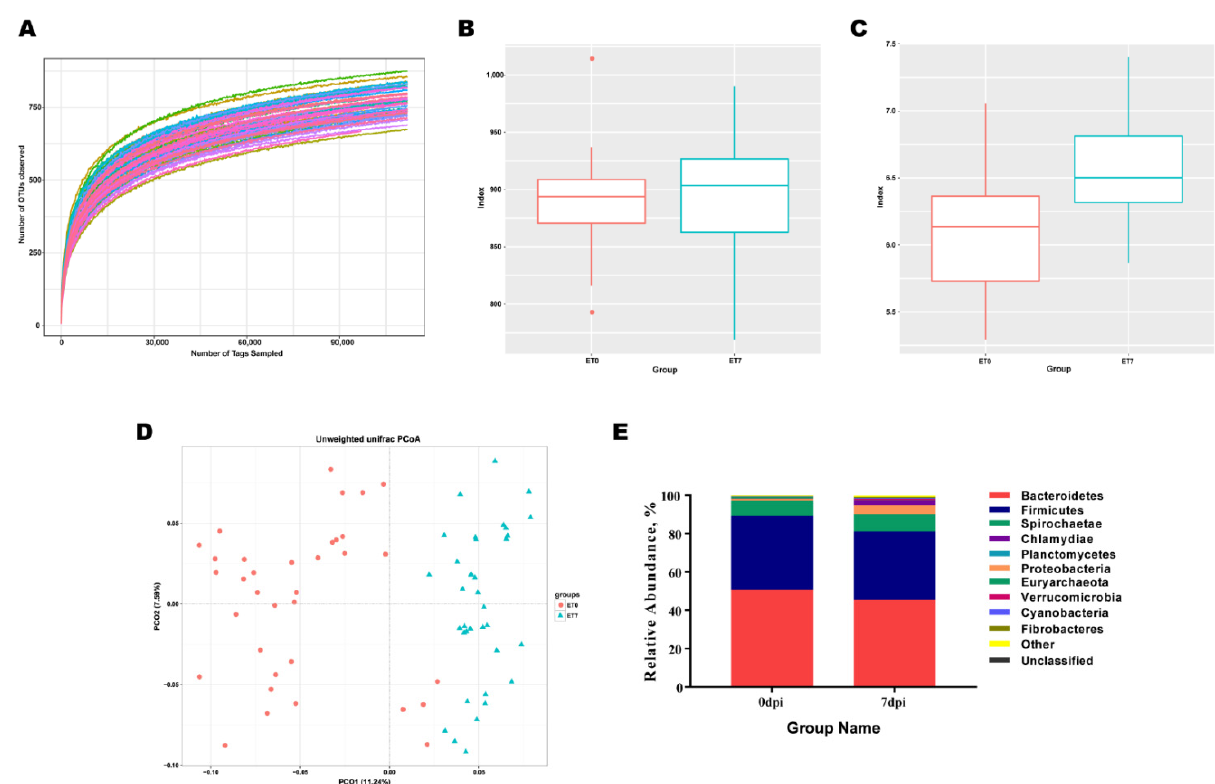
Figure 1. Characterization of sequencing output. ( A ) Rarefaction curves. Each curve represents each pig. ( B ) Chao1 index. ( C ) Shannon index. Different letters above the bars denote a significant difference in alpha diversity index among the groups tested by Wilcoxon signed-rank test and adjusted for false discovery rate (FDR, p < 0.05). ( D ) 2D-PCoA plots of gut microbiota of 0 dpi (red circle) or 7 dpi (blue triangle), based on unweighted UniFrac distance in microbial communities. ( E ) Community bar plot analysis of bacterial at the phylum level, only the top 10 species with expression abundance of 2% were displayed, the rest were classified into the other category, and tags that cannot be annotated to this level were classified into the unclassifiedcategory.